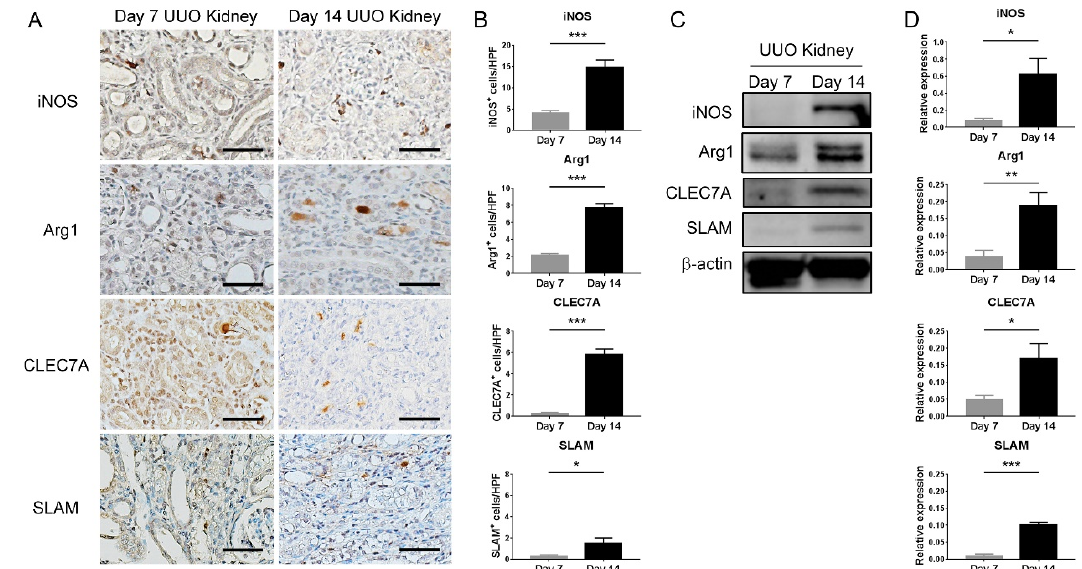
Figure 2. M1 and M2a macrophage infiltrates predominate in the late stage of unilateral ureteral obstruction (UUO). ( A ) Representative immunohistochemical photomicrographs of inducible nitric oxide synthase (iNOS), arginase-1 (Arg1), C-type lectin domain family 7 member A (CLEC7A) and signaling lymphocytic activation molecule (SLAM) in day 7 and day 14 obstructed kidneys. Scale bar = 25 µ m. ( B ) Quantification of the iNOS-, Arg1-, CLEC7A- and SLAM-positive interstitial cells in day 7 and day 14 obstructed kidneys. * p < 0.05 and *** p < 0.001 by the unpaired Student’s t -test; n = 5 for each group. ( C ) Western blot analyses of iNOS, Arg1, CLEC7A and SLAM expressions in day 7 and day 14 obstructed kidneys. β -actin served as the loading control. ( D ) Quantification of the Western blot analyses. * p < 0.05, ** p < 0.01 and *** p < 0.001 by the unpaired Student’s t -test; n = 5 for each group.